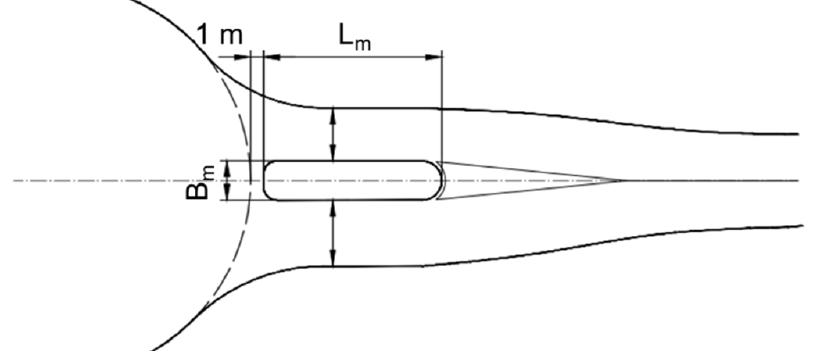
Figure 13. Radial splitter island elements for suburban roundabouts according to [7,8].